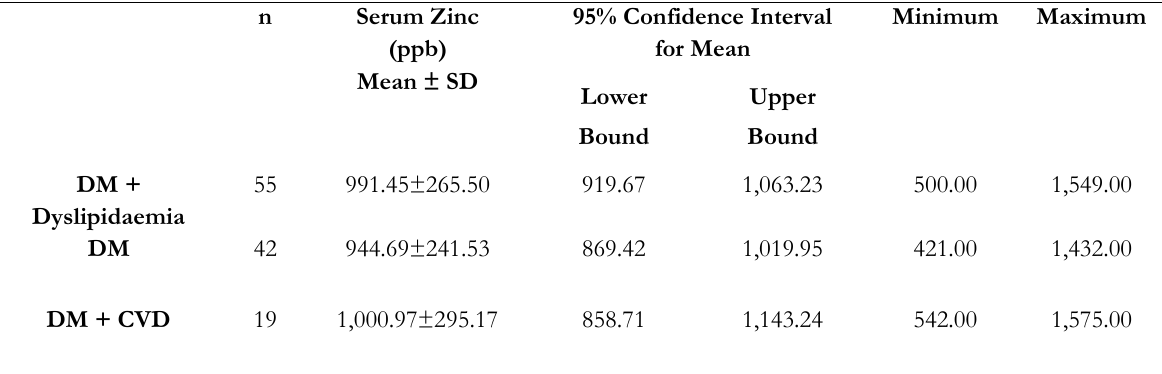
Table 2: Mean serum levels of the three